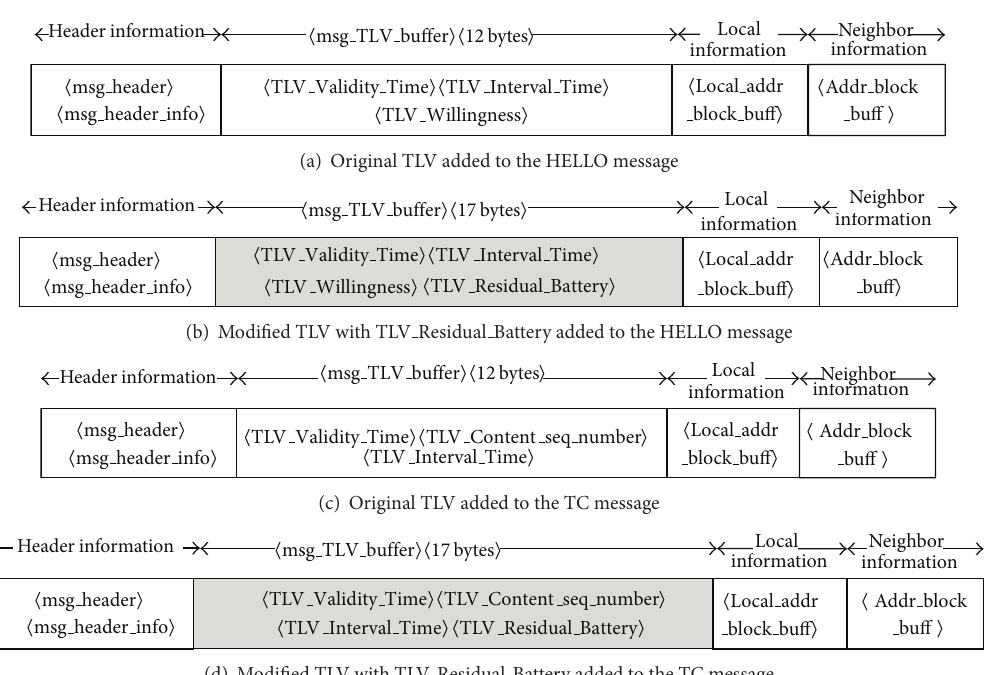
Figure 2: Type-length-value (TLV) added to HELLO and TC messages in